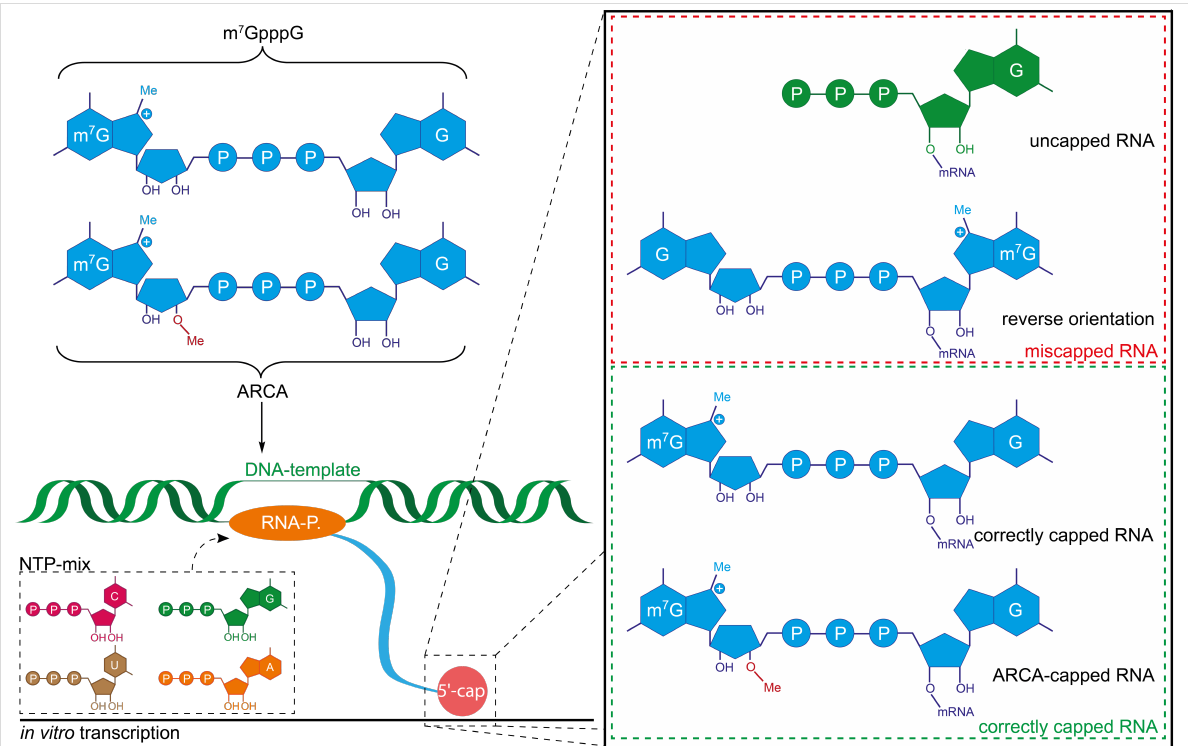
Figure 3: Schematic representation of co-transcriptional capping with different cap analogues. A DNA-dependent RNA polymerase initiates transcrip- tion from a DNA template by incorporation of a cap analogue, thereby producing capped RNA. When m 7 GpppG is used as a cap analogue, miscapped RNA with the cap analogue incorporated in its reverse orientation is produced in addition to the correctly capped RNA. With the ARCA cap, reverse incorporation is excluded [48].